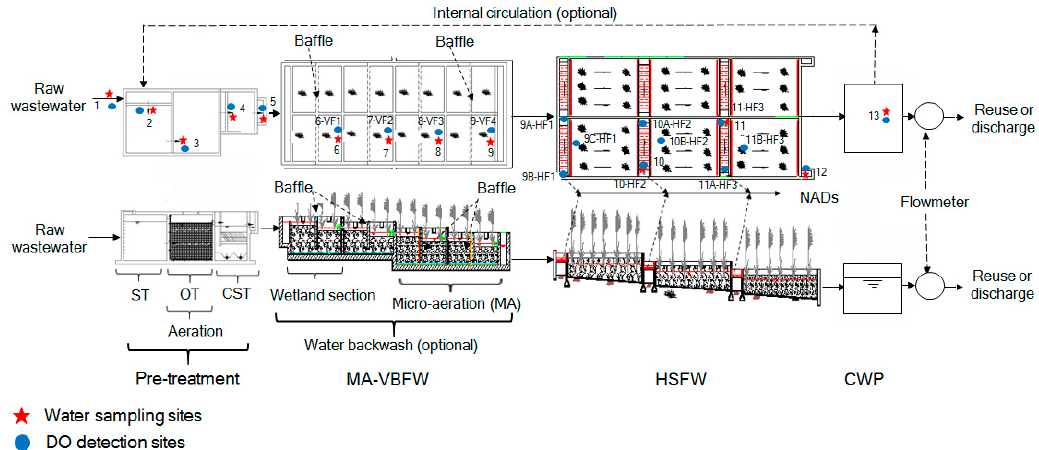
Figure 1. Schematic diagram of the studied full ‐ scale hybrid system along with the sampling sites.